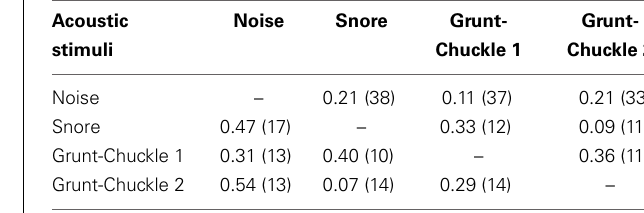
three exemplar auditory units. The bottom row summarizes the modulation in the number of spikes per stimulus. Red arrows mark electrical stimulation artifact. Asterisk notes statistically significant